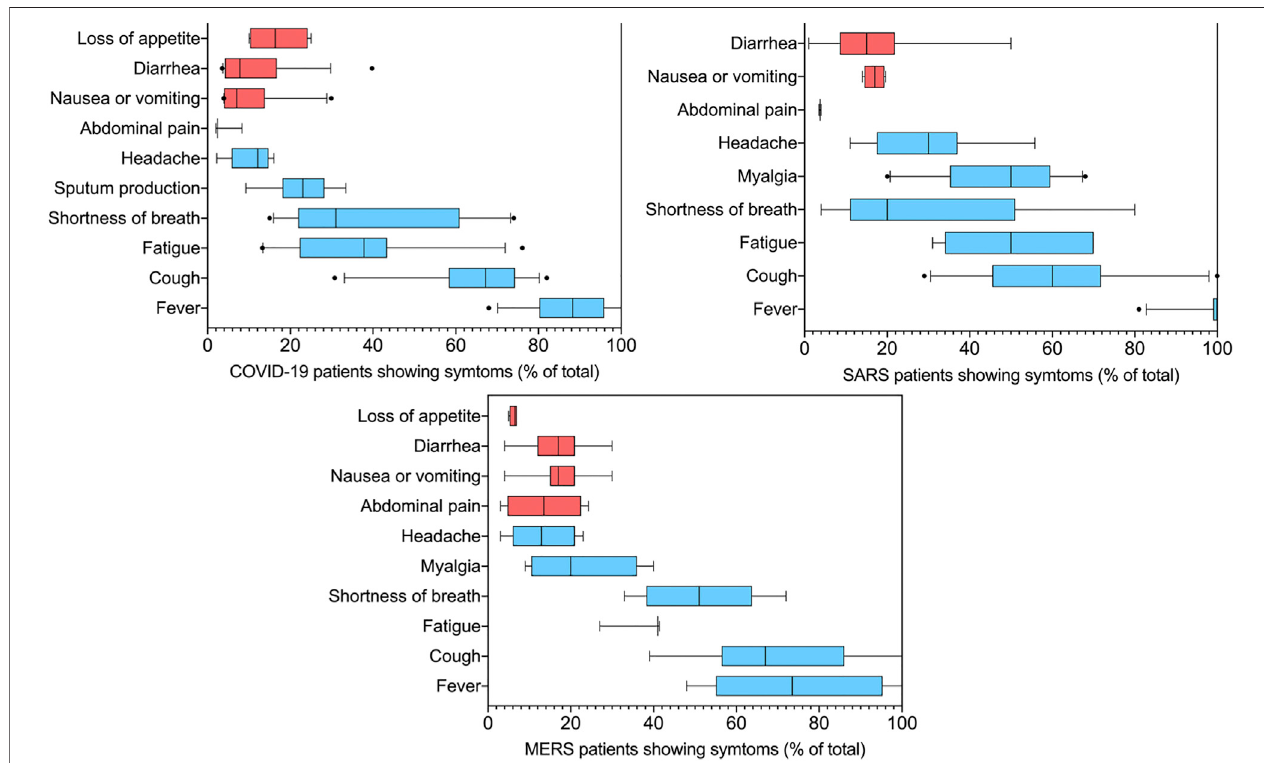
FIGURE 1 | Summary of symptoms feature of COVID-19, SARS, and MERS. The data is the summary of 16 independent reports involving a total of 7322 COVID- 19 patients, 10 independent reports involving a total of 1299 SARS patients, nine independent reports involving a total of 783 MERS patients. The red bars are those associated with gastrointestinal problems. In the box plots, the boundary of the box closest to zero indicates the 25th percentile, a black line within the box marks the median, and the boundary of the box farthest from zero indicates the 75th percentile. Whiskers above and below the box indicate the 10th and 90th percentiles. Points above and below the whiskers indicate outliers outside the 10th and 90th